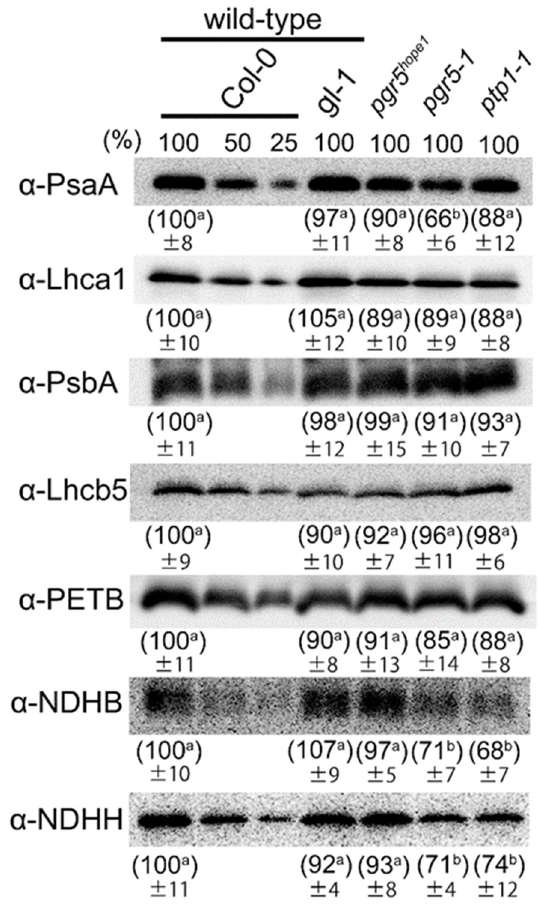
Figure 4. The immunoblotting of proteins in photosynthetic electron transport. Proteins in photosyn- thetic electron transport were detected with specific antibodies in each plant. Leaves were samples after measurements of photosynthetic parameters (Figure 5). Samples were loaded based on the same leaf area. The experiment was repeated at least three times with similar results. The values in parentheses show relative values of band intensities when the wild-type Col-0 is 100. Data are means ± sd. ( n = 3–4) Different alphabets beside the numbers indicate the significant difference analyzed by Tukey’s HSD test ( p < 0.05). The images were representative.